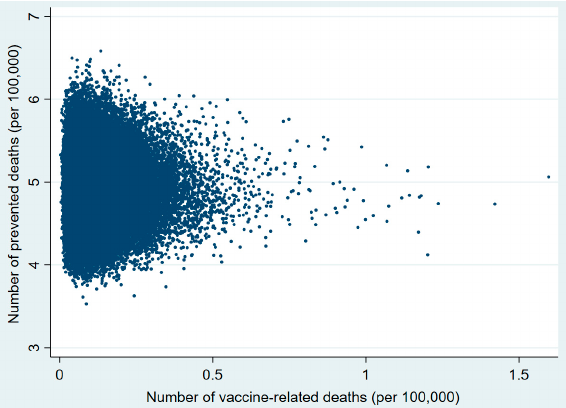
Figure 5. Probabilistic sensitivity analysis. Number of vaccine-prevented deaths for COVID-19 (ben- efit) vs. vaccine-related deaths for disseminated intravascular coagulation and cerebral venous sinus thrombosis (risk) after 100,000 simulations. Individuals aged 30–49 years, Italy.